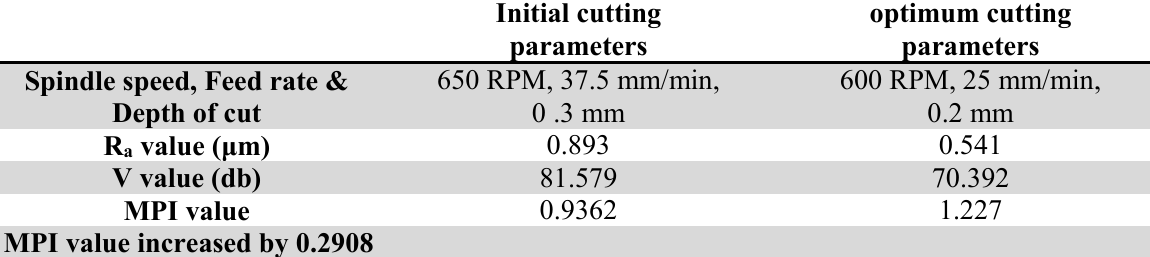
Comparison of machining performances using initial and optimal cutting